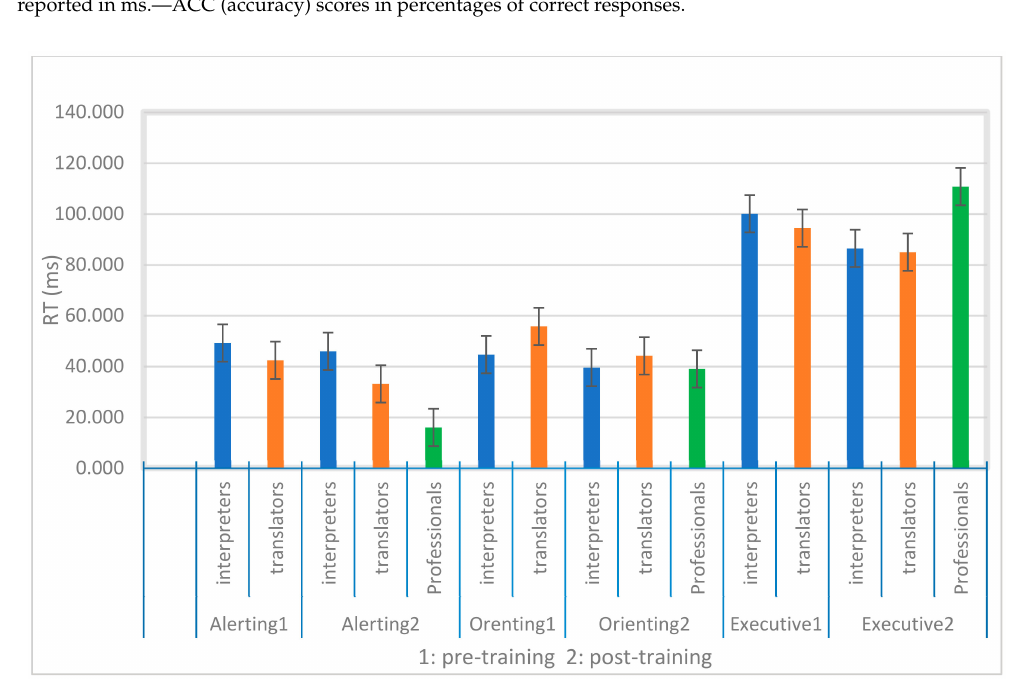
Figure 2. Attention network scores for response times (RTs). Error bars indicate standard